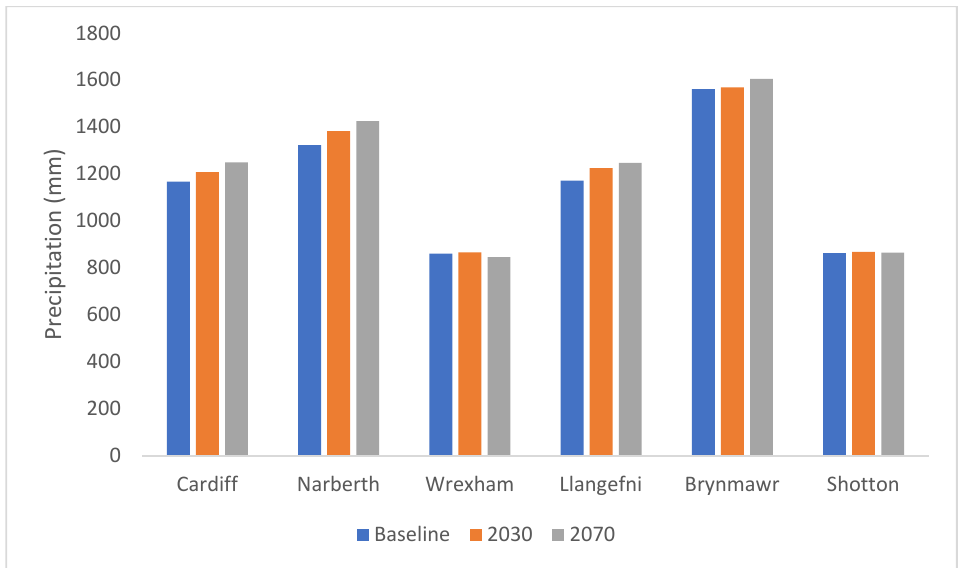
Figure 8. Annual profile of average monthly precipitation in Cardiff for baseline, 2030 and 2070 .